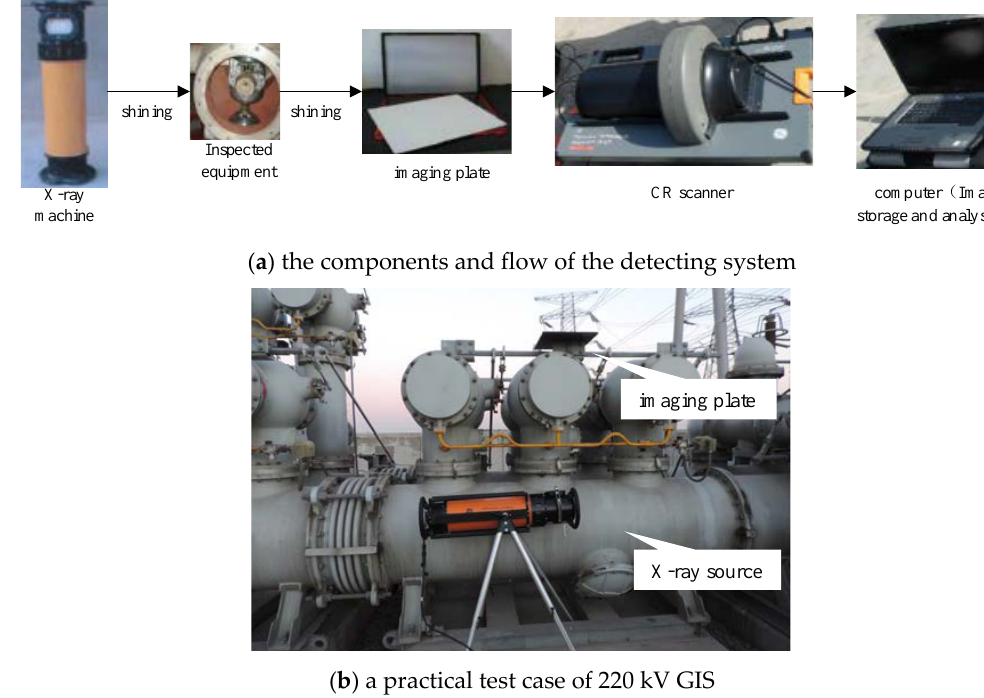
Figure 2. X-ray digital imaging system and a practical test case.